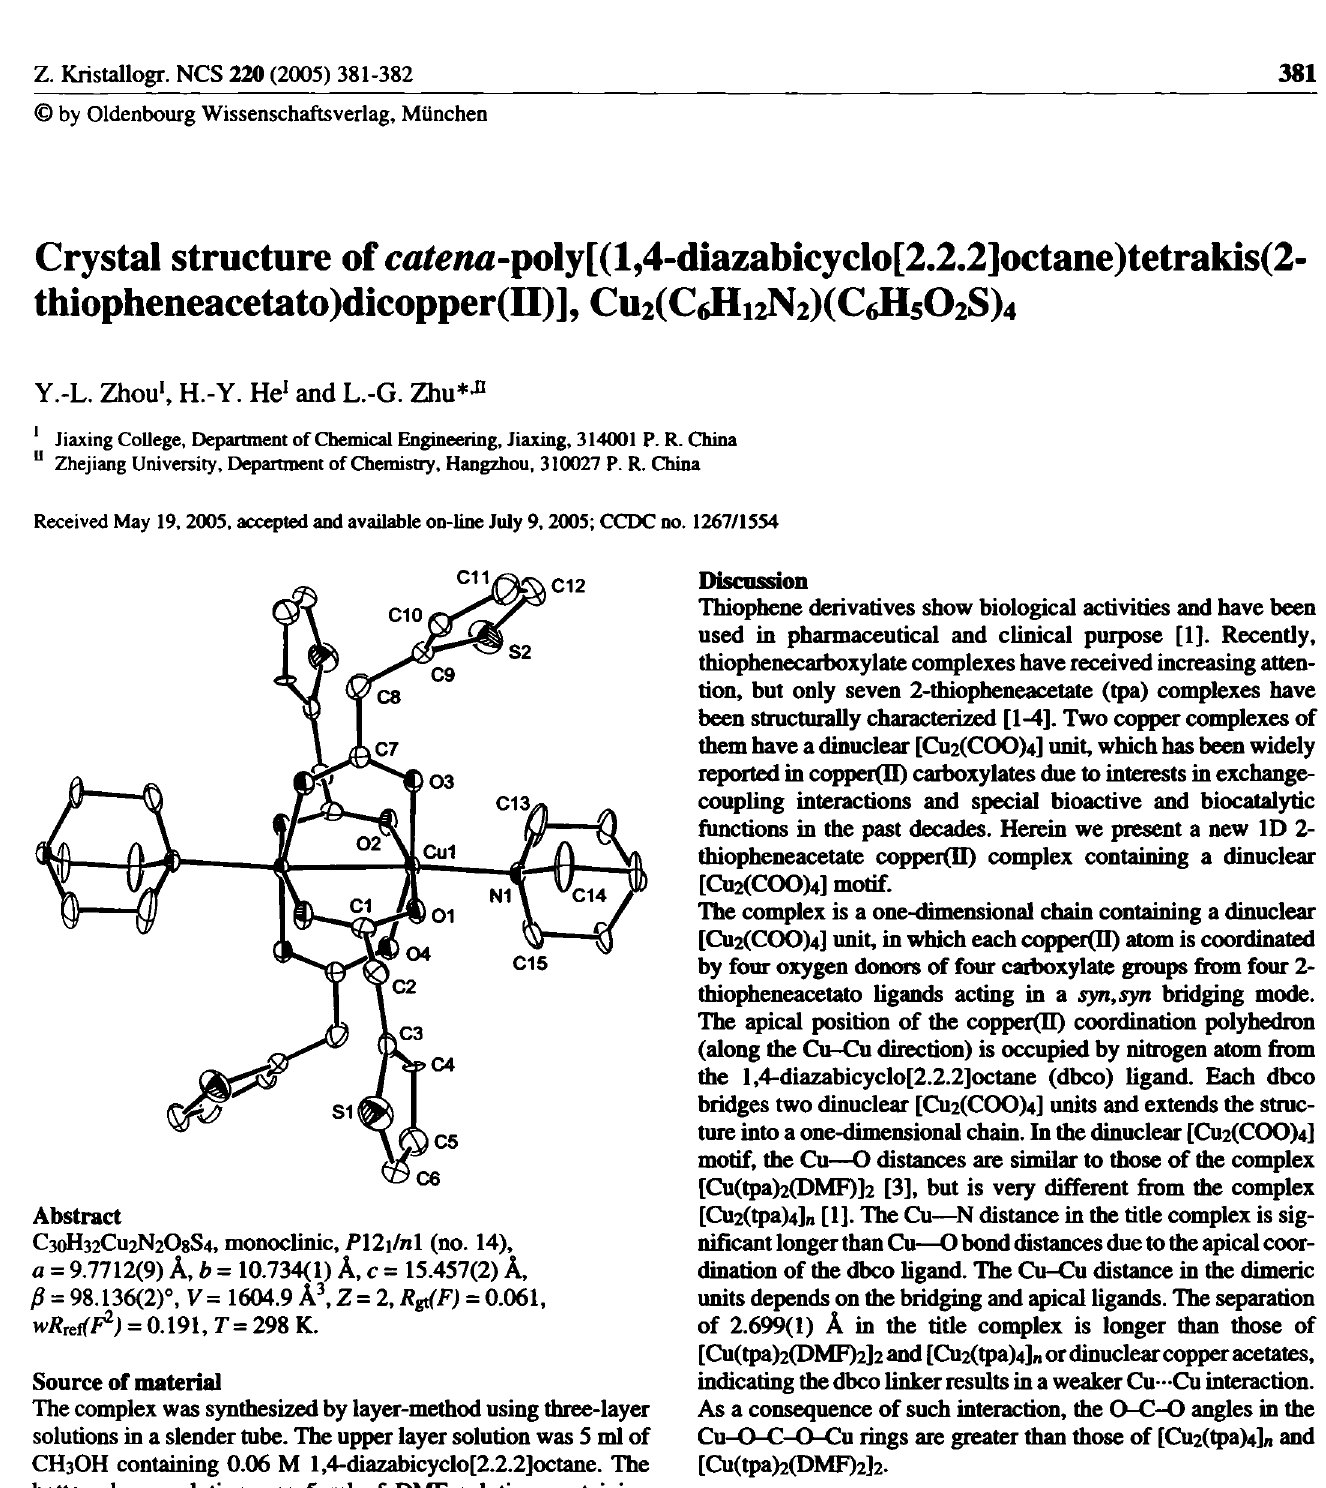
Table 1. Data collection and